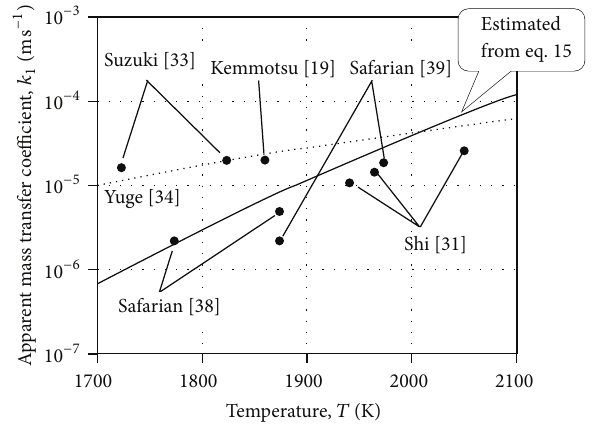
and 𝑊 during melting at (a) 1800 and (b) 2000 K. P Si